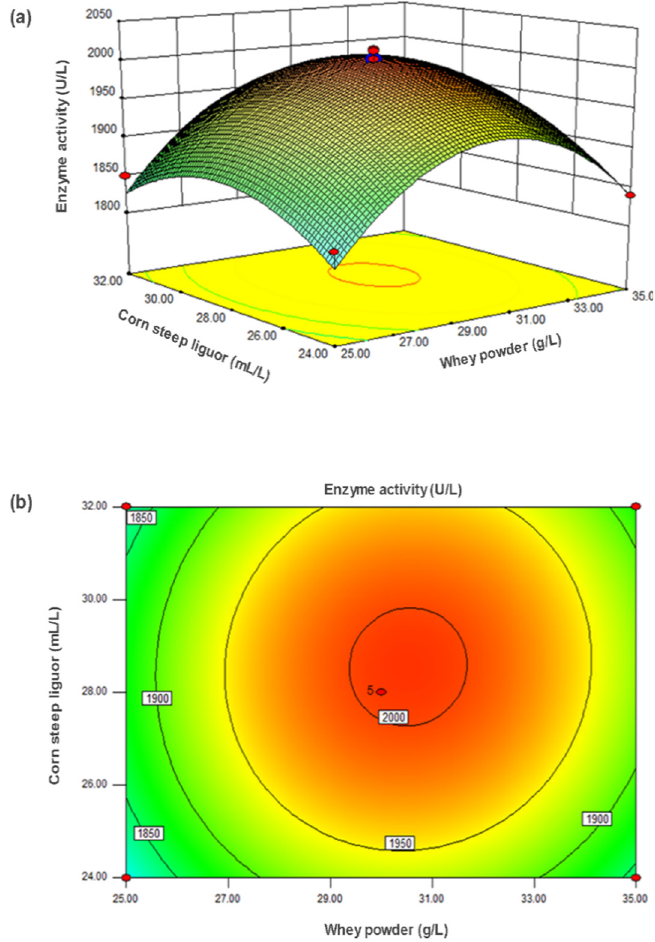
Figure 3. Effects of whey powder and corn steep liquor on enzyme production by L. bulgaricus L3; ( a ) response surface plot; ( b ) contour plot. ( a ) response surface plot; ( b ) contour